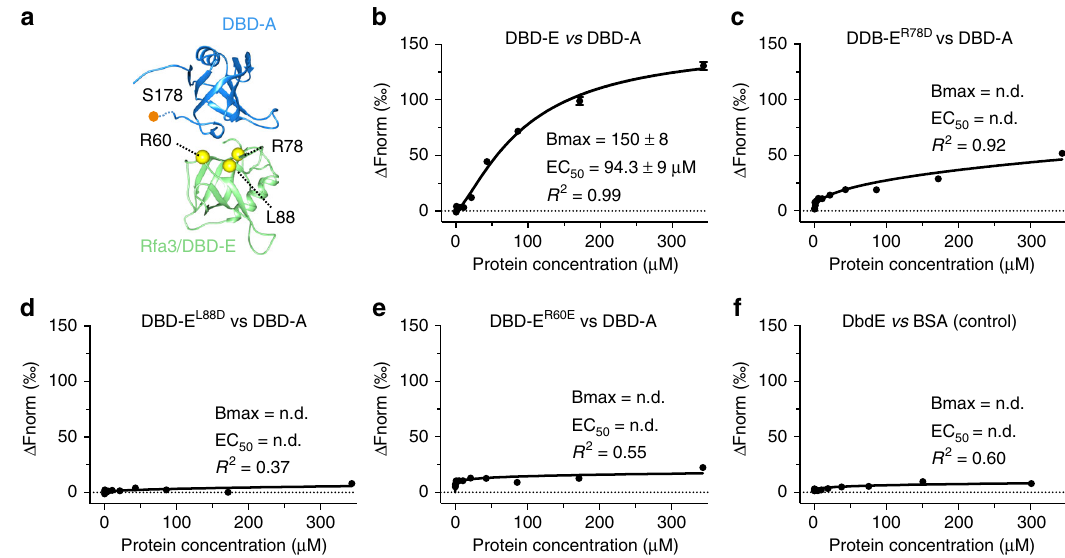
Fig. 5 Investigation of the DBD-A – DBD-E interaction. a A proposed model for the interaction between Rfa1-DBD-A (blue) and Rfa3 (green) based upon the interaction interface between Ustilago maydis DBD-A and Rfa3 in the crystal structure asymmetric unit. The model was created using the yeast DBD-A NMR structure (pdb 1ynx) and the re fi ned Rfa3 model from our cryo-EM data, superposed onto DBD-A and Rfa3 of pdb 4gop. Residues R78, L88, and R60 that we mutate in this study are located at the interface and are illustrated by yellow spheres. A Mec1-dependent DBD-A phosphorylation site (S178) close to the interaction interface is labeled. b – e Microscale thermophoresis (MST)-binding curves using puri fi ed DBD-A versus fl uorescently labeled Rfa3-OB domain (residues 1 – 99) together with binding curves for the Rfa3-OB point mutants (substitutions given above curves). Normalized fl uorescence was calculated using NanoTemper Analysis 1.2.101 and is plotted as function of DBD-A concentration. The apparent effective half maximal binding (EC 50 ) was calculated by fi tting using the hill equation in Prism and is given for each binding experiment together with the calculated maximum fl uorescence (Bmax) and R 2 of the fi t. n.d. denotes not determined. f Bovine serum albumin (BSA) control for non-speci fi c binding is also shown. Each experiment was performed in triplicate with each data point an average with standard error of the mean (SEM) shown. Source data are provided as a Source Data fi